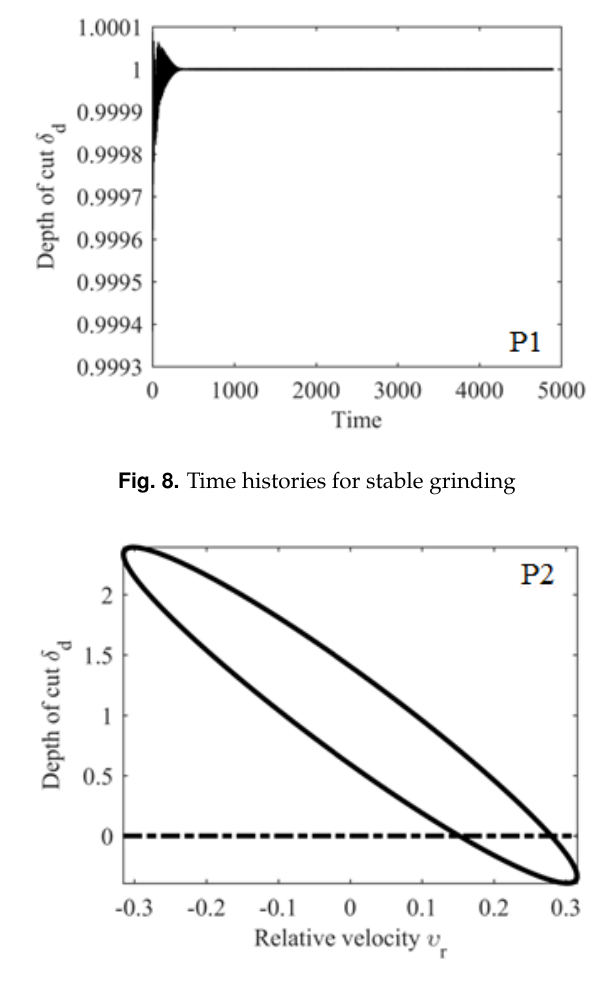
Fig. 9. Phase diagram for unstable